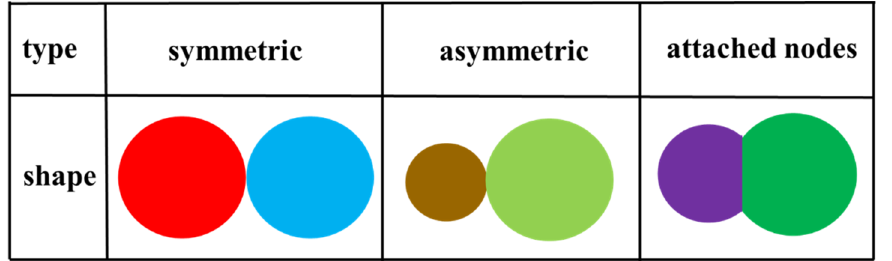
Scheme 1. Different types of Janus dumbbell particles. Different colors indicate the different surface properties of each particle.